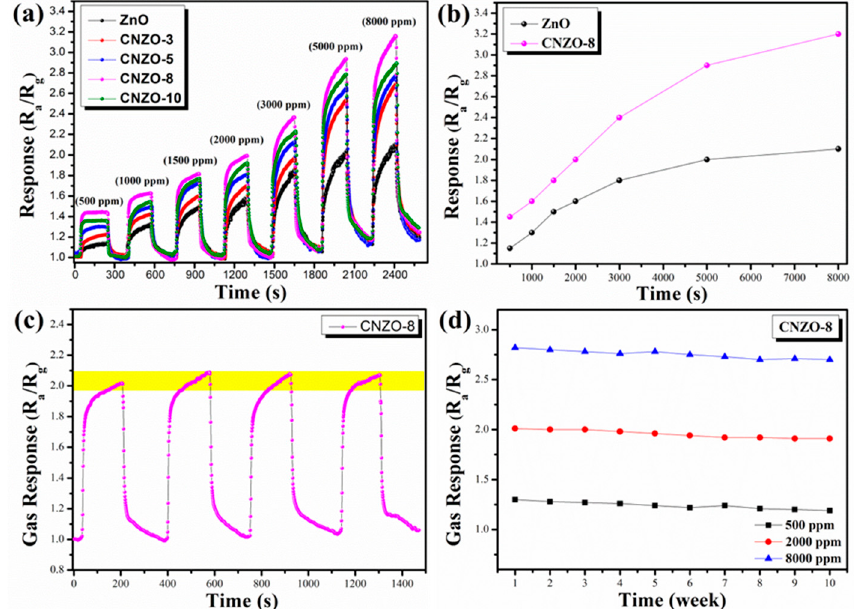
Figure 9. ( a ) UV light-activated dynamic response-recover curves of the g-C 3 N 4 / ZnO sensors to different concentrations of CH 4 at room temperature, ( b ) gas responses of two sensors as a function of the ethanol concentration at room temperature, ( c ) repeatability measurements of the CNZO-8 sensor towards 2000 ppm CH 4 at room temperature, ( d ) long-term stability test of CNZO-8 sensor to three concentrations of CH 4 at room temperature.